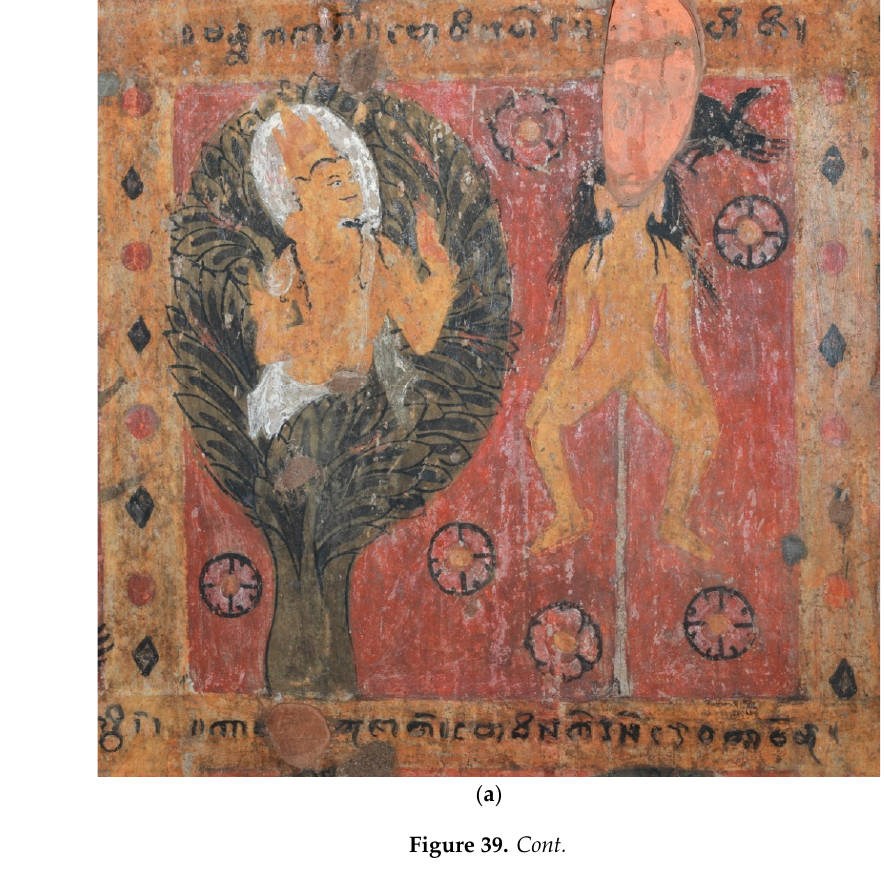
Figure 38. Pagan, Hpetleik Stupa, 11th century. Two hell plaques—one uninscribed, humans protecting their heads, surrounded by tied up bodies awaiting their turn. The second image is badly damaged but reads Tulakutanirayam (false weight hell). ( a ) subtitle, ( b )